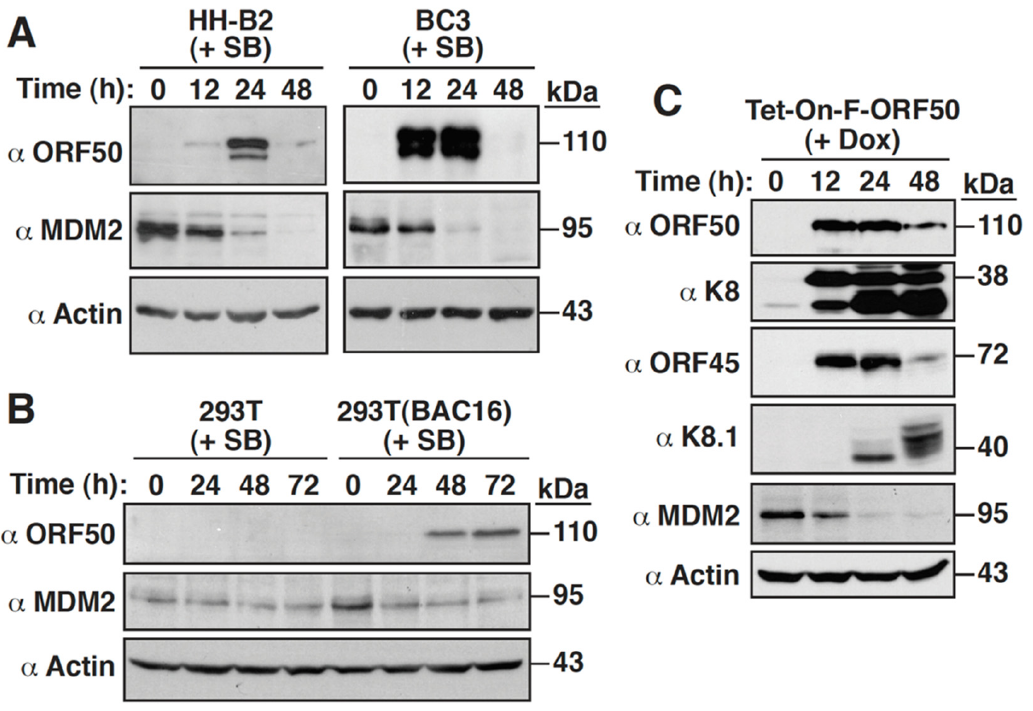
Figure 1. Downregulation of MDM2 occurs during the KSHV lytic cycle. ( A ) Expression kinetics of MDM2 in HH-B2 and BC3 cells during the KSHV lytic cycle. The expression of MDM2 and the viral lytic protein ORF50 was analyzed by Western blotting in HH-B2 and BC3 cells after treatment with sodium butyrate (SB) for 12, 24, and 48 h. ( B ) Western blot analysis of MDM2 expression in 293T and 293T(BAC16) cells after treatment with SB. At the indicated time points after SB treatment, the expressions of MDM2 and ORF50 in the treated cells were determined by immunoblotting. ( C ) Western blot analysis of MDM2 and viral lytic proteins expressed in HH-B2(Tet-On-F-ORF50) cells after treatment with doxycycline (Dox). Note that the viral proteins ORF50, K8, and ORF45 belong to the immediate-early or early lytic proteins, whereas K8.1 is a late lytic protein.